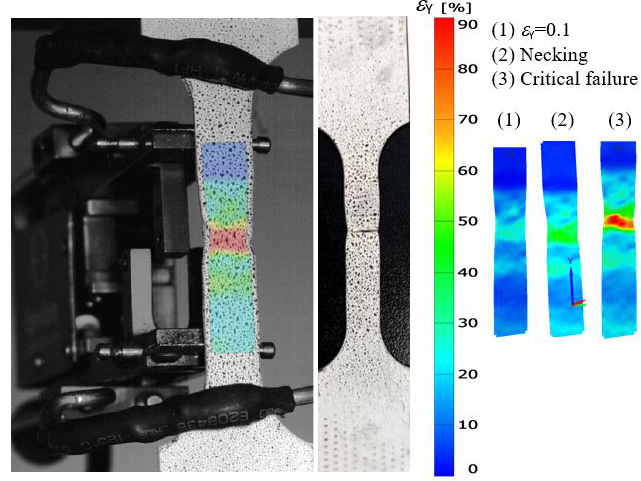
Figure 14. The strain cloud diagram of the specimen.